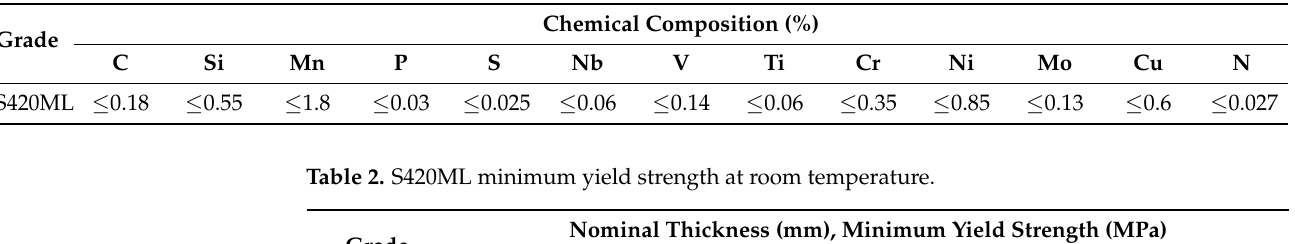
Table 1. S420ML chemical composition.